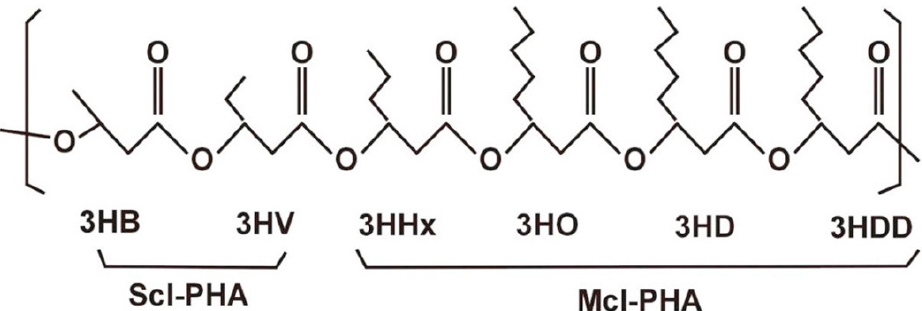
Figure 5. General structure of short chain length and medium chain length PHA [4].